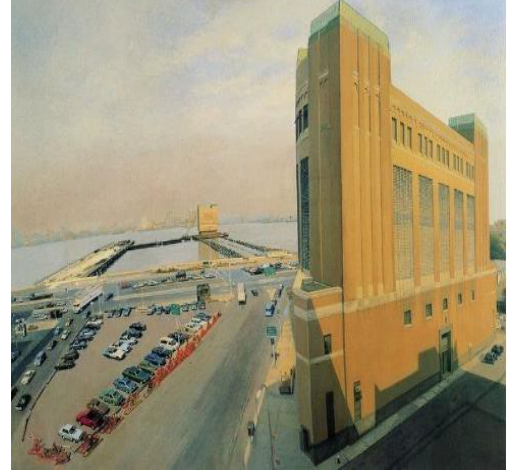
Fig. 17 Ventilation Tower with Estivating Snow Plows, 1988 Fig. 18 Demolition and excavation on the site 1983- oil on